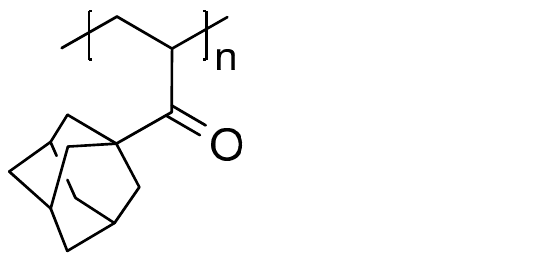
Figure 2. The structure of poly(adamantyl vinyl ketone).